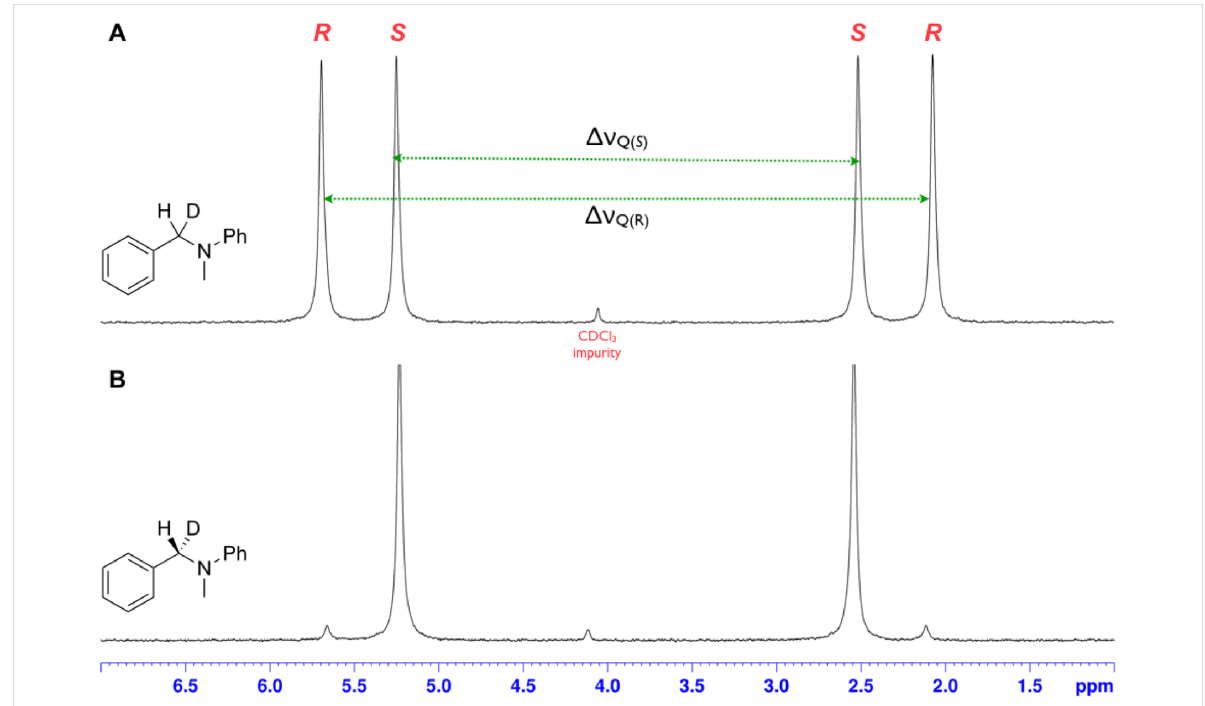
Figure 3: Partial 2 H{ 1 H} NMR (107.5 MHz) with PBLG in CHCl 3 (13% w/w). (A) racemic sample of 6 (from Table 1, entry 2) and (B) enantioenriched sample of 6 (from Table 2, entry 2). The magnitude of the quadrupolar splittings for the ( R )- and ( S )-enantiomers are labelled Δν Q(ent) . The ee of each sample was determined by deconvolution of the line shapes and subsequent integration.